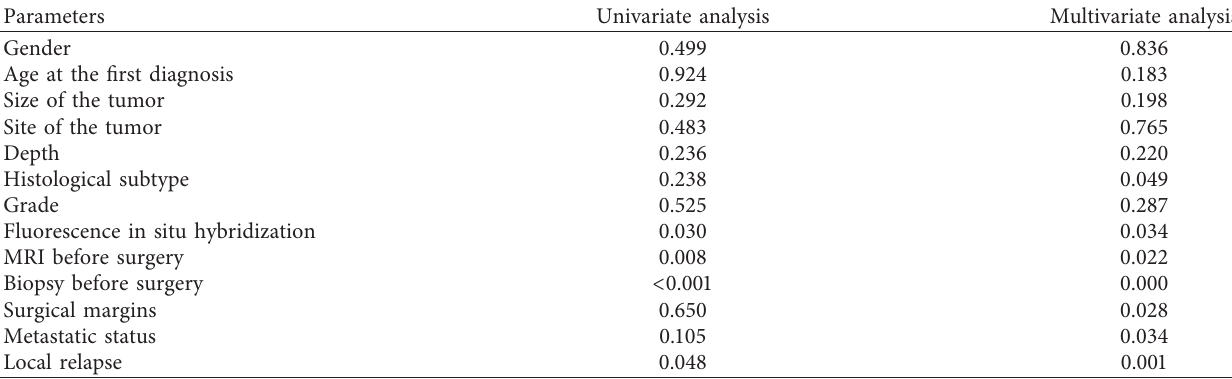
Table 3: Multivariate